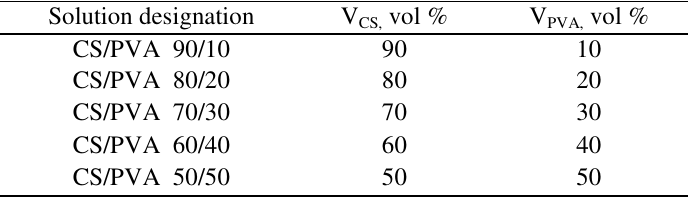
Table 1. Composition of the chitosan and PVA